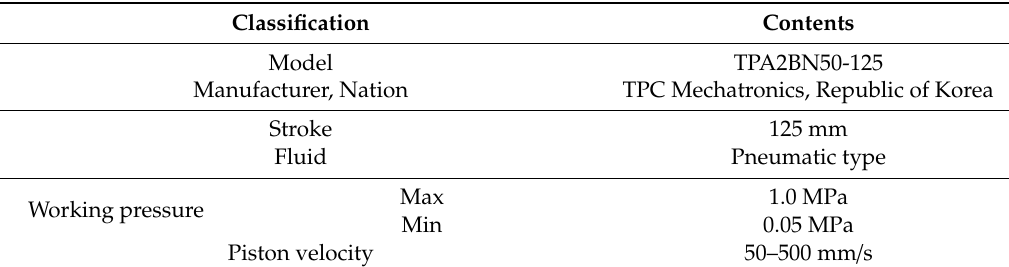
Figure 6. View of pneumatic-type actuator. Table 2. Specifications of pneumatic-type